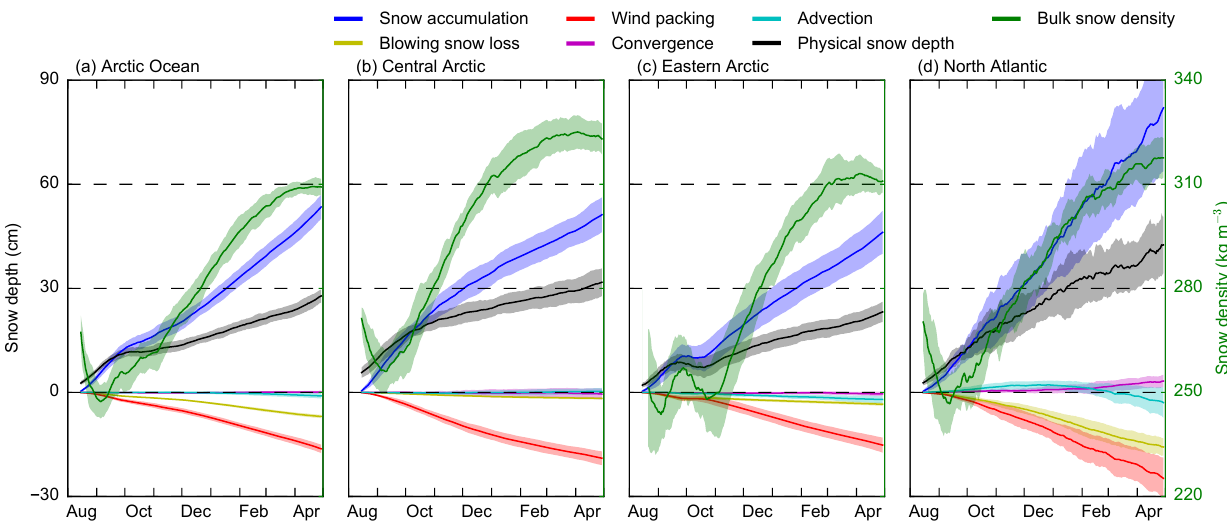
Figure 7. Seasonal snow budget evolution across the four study regions (shown in Fig. 5), initiated from 15 August 2000 to 2014 and run until 1 May of the following year using the default/MEDIAN-SF NESOSIM simulations. The thick lines show the mean daily regional values over this time period, while the shaded areas represent the interannual variability (1 standard